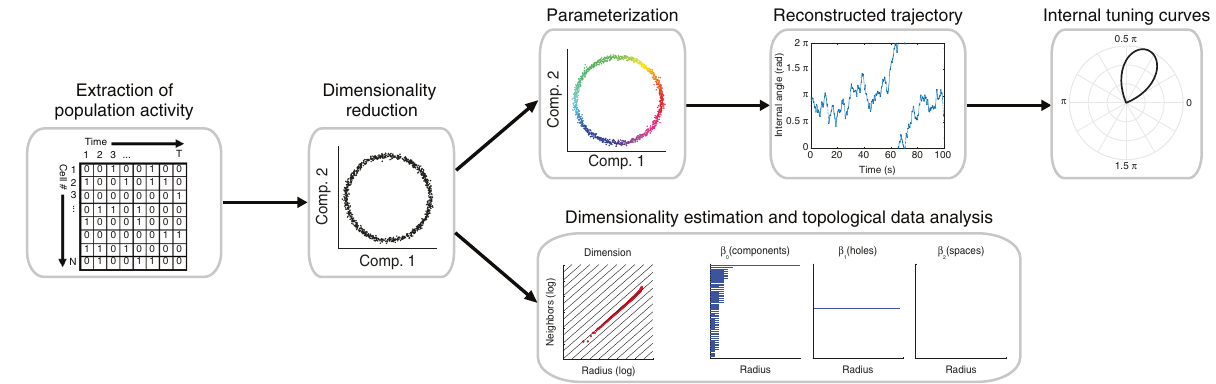
Fig. 6 Key steps for unsupervised exposure of the internal structure of neuronal activity and the reconstruction of internal representations. First, the population neuronal activity is binarized and temporally binned into N -dimensional activity vectors ( N = number of neurons). A dimensionality reduction algorithm is then applied to the activity vectors, embedding the data and exposing its internal structure within a low-dimensional space. Next, the activity in the reduced space is parameterized using a clustering algorithm. This allows the reconstruction of the trajectory of neuronal activity and the internal tuning curves of individual neurons as a function of the parameterized variable. In parallel, the dimension and topology of the data in the reduced space can be estimated to reveal key properties of the internal